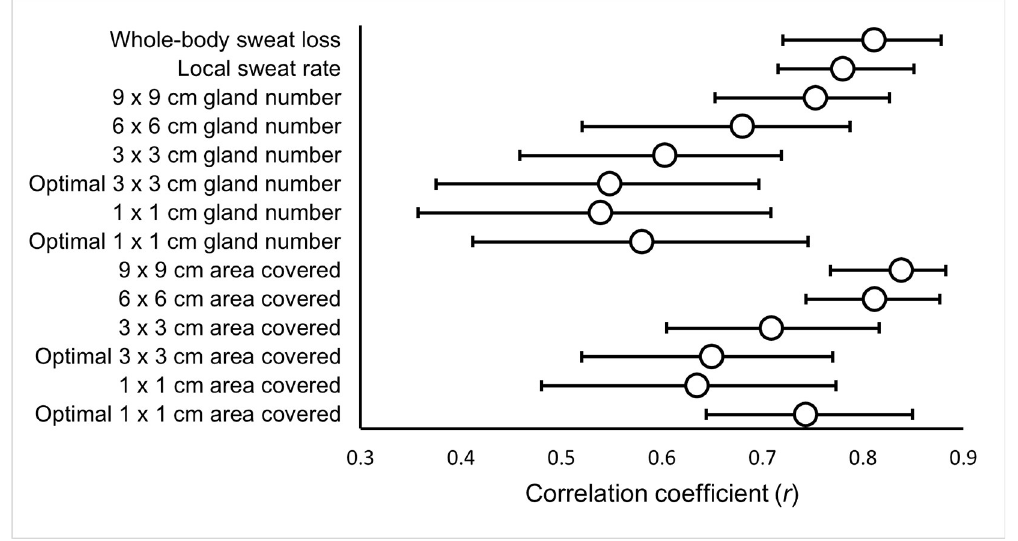
Fig 3. The relationship between relative heat production (H˙ prod ) and measures of the sweating